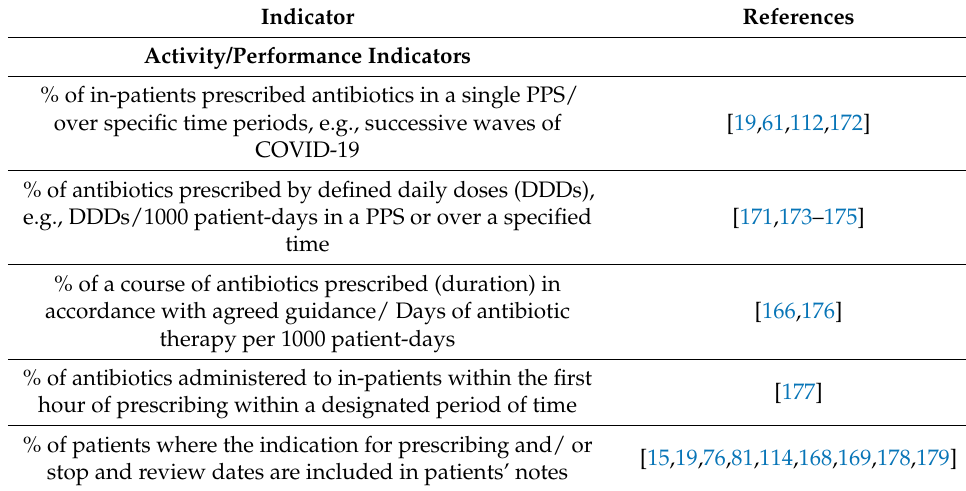
Table 2. Indicators that have been used among in-patients in hospitals across Africa to assess the prescribing of